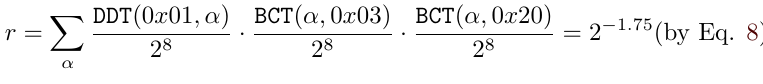
Similarly, the cell at (3,3) before SC and AC of R4 is outlined in purple, meaning its upper crossing difference propagates through the purple cells from the upper differential